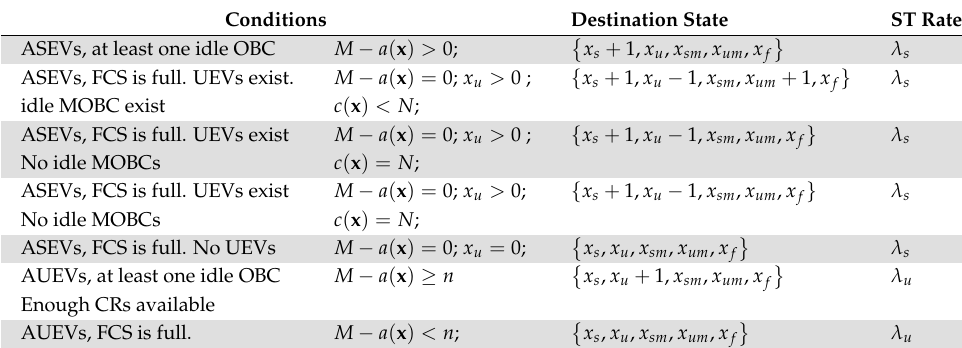
Table 2. STs from x triggered by EV arrivals.